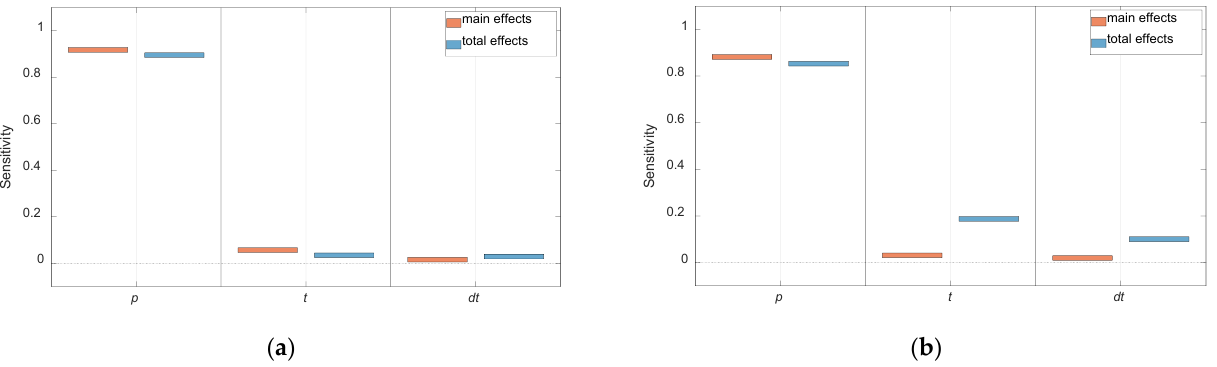
Figure 19. Sensitivity of average output power and power fluctuation index. ( a ) Sensitivity of average output power. ( b ) Sensitivity of power fluctuation index .